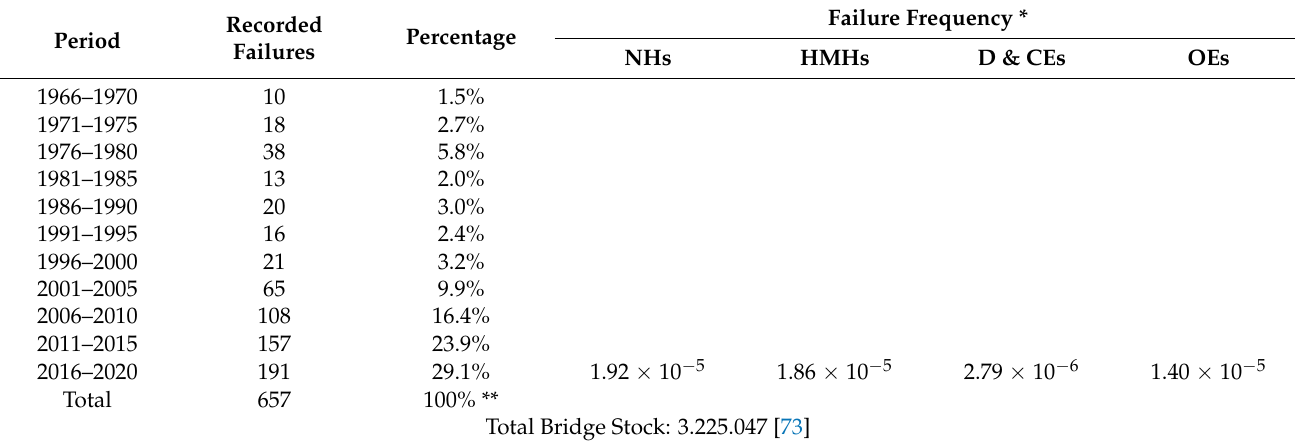
Table 4. Rate of failure of existing bridges (data extracted from: [71]).